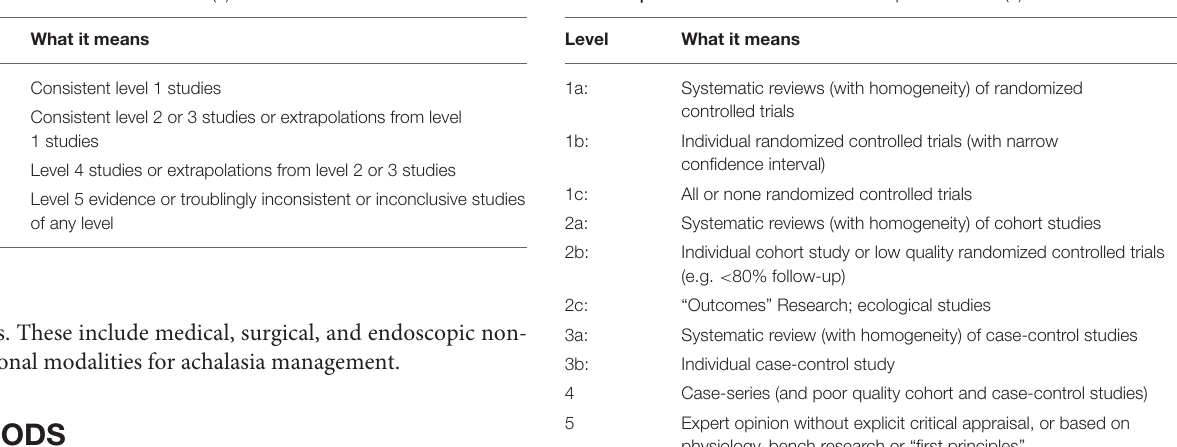
TABLE 1 | GRADE of recommendation (9). TABLE 2 | Oxford level of evidence for therapeutic studies